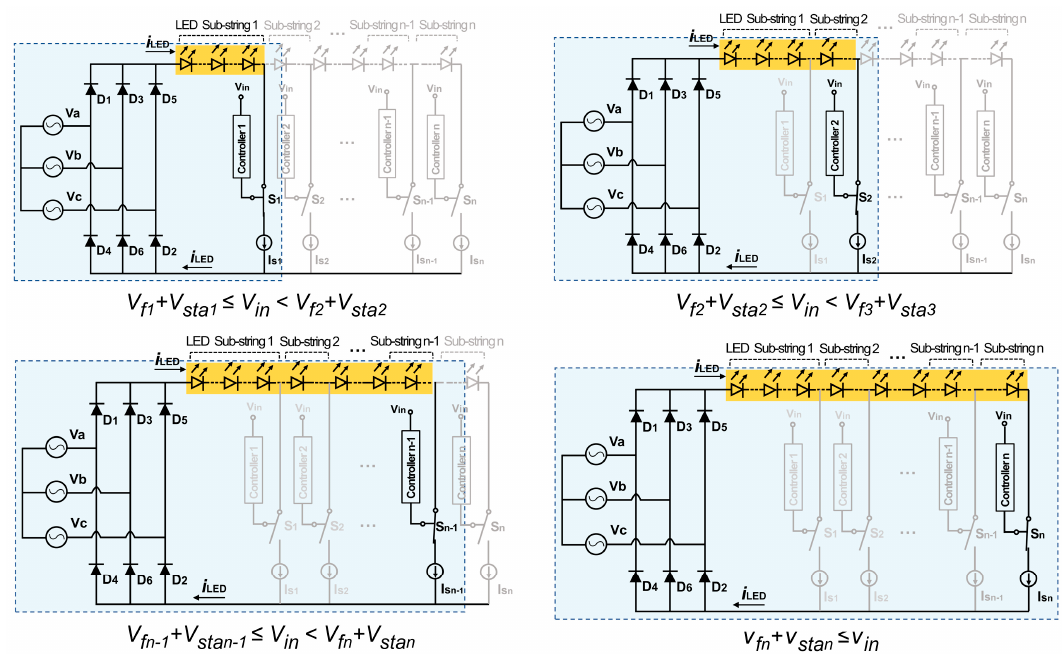
Figure 2. Equivalent circuits of the multi-string GaN LED driving at different V in .